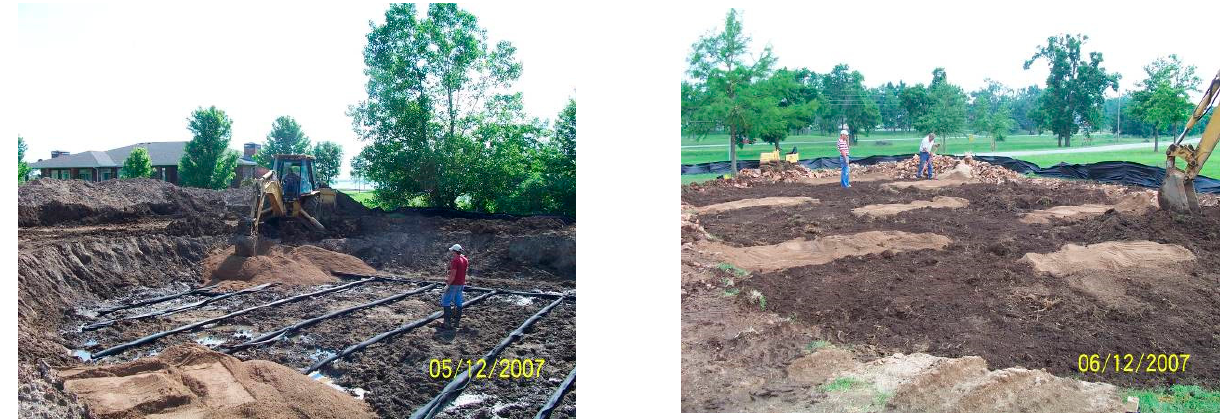
Figure 3. BRC during construction; ( left ) Grand Lake Association, ( right ) Grove High School.